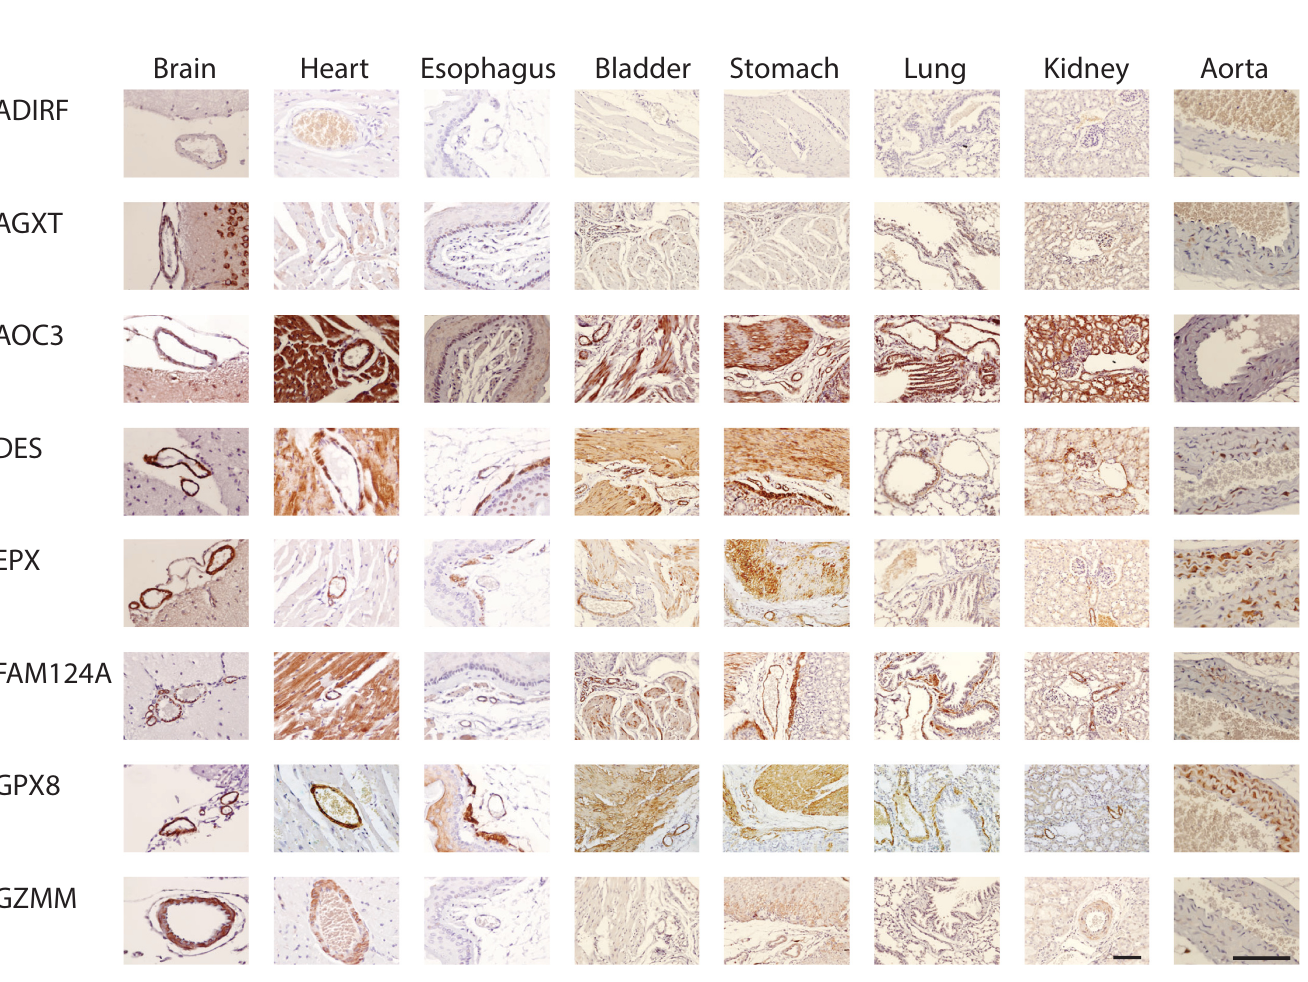
Fig 1. Smooth muscle protein expression in mouse tissues. All antibodies against listed proteins were first validated on human brain as localizing to cerebral vascular smooth muscle. The same antibodies were used on mouse tissues shown here. With few exceptions, protein was localized to mouse cerebral vascular smooth muscle (first column on the left) and to both vascular and non-vascular smooth muscle in other tissues. In lung, non-vascular smooth muscle around the airways was analyzed. In bladder and stomach, non-vascular smooth muscle is shown in the same field as arteries to serve as a comparison for staining intensity on both cell types. The brain, heart, and aorta were viewed at 400X and all other tissues were viewed at 200X; the scale bar is 100 microns for all tissues.